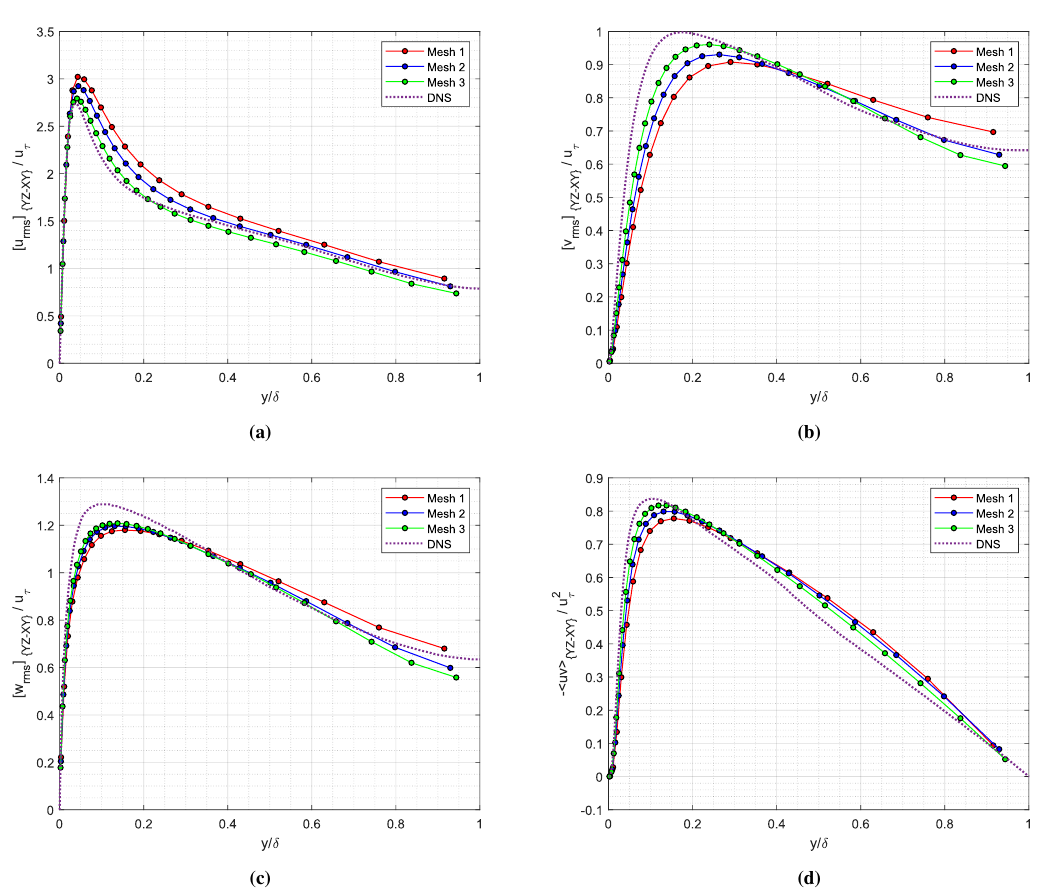
Figure 4: Comparison of RMS of velocity fluctuations for different mesh resolutions Figure 4. Comparison of RMS of velocity fluctuations for different mesh resolutions for ( a ) stream-wise, ( b ) wall-normal, ( c ) span-wise and ( d ) shear